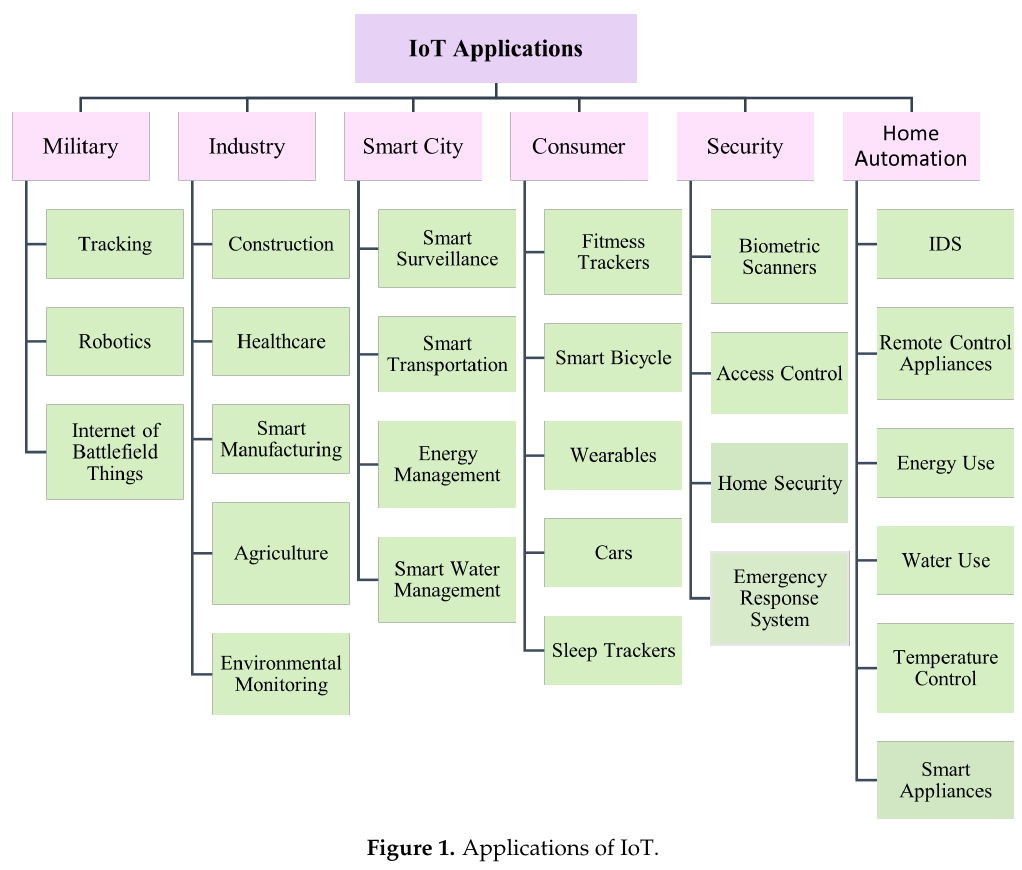
Figure 1. Applications of